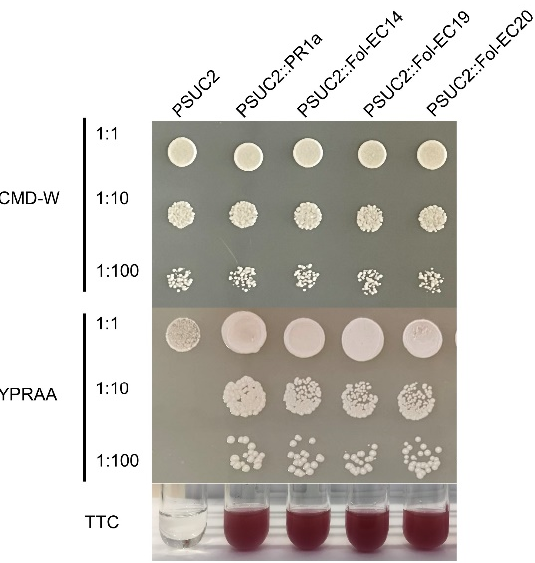
Figure 7. Yeast secretion trap assay of the predicted signal peptides of cell-death inducing and cell-death suppressing effector candidates. The predicted signal peptide coding sequences of Fol- EC14 , Fol-EC19 , and Fol-EC20 were cloned into the yeast secretion trap vector pSUC2. The tobacco PR1a signal peptide was used as a positive control and empty vector was used as a negative control. CMD-W (-Trp) was used to select the transformed yeast YTK12 carrying the pSUC2 vector. Yeast growing on the YPRAA medium indicate secretion of invertase via a functional signal peptide. Conversion of the dye 2, 3, 5-triphenyltetrazolium chloride (TTC) to the insoluble red colored triphenylformazan is also indicative of invertase